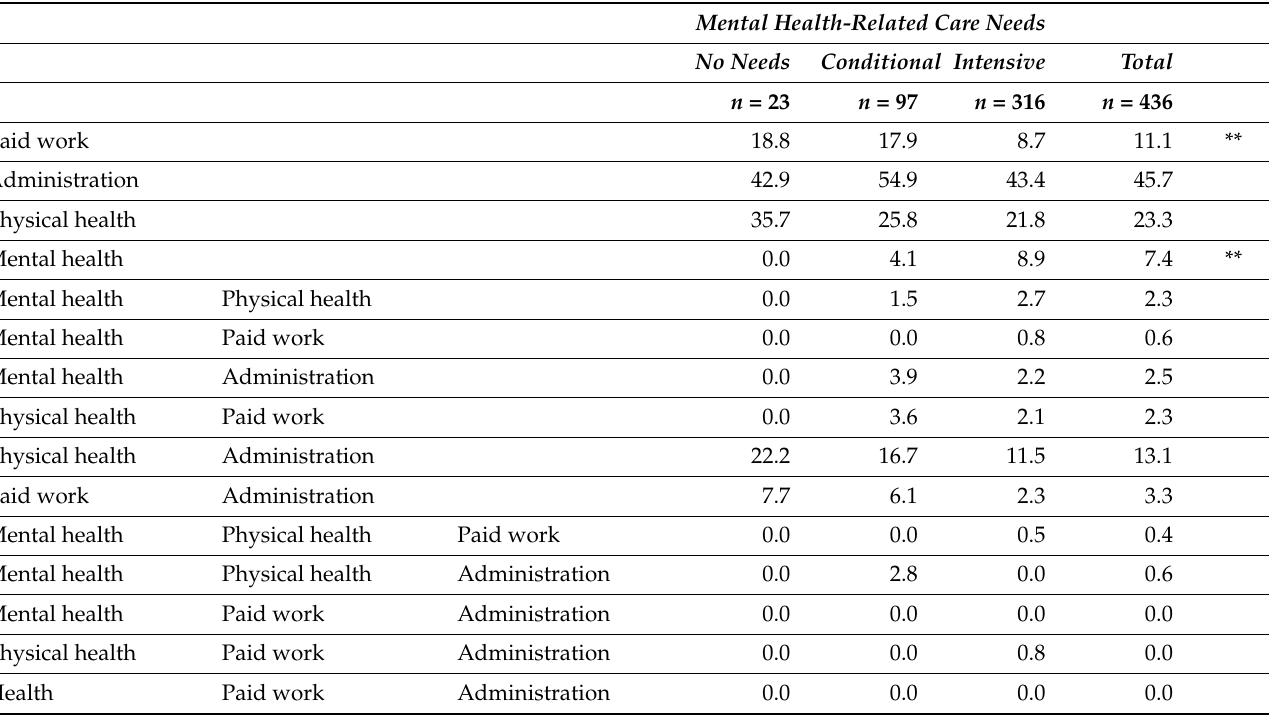
Table 4. Focus of delivered services in relation to present